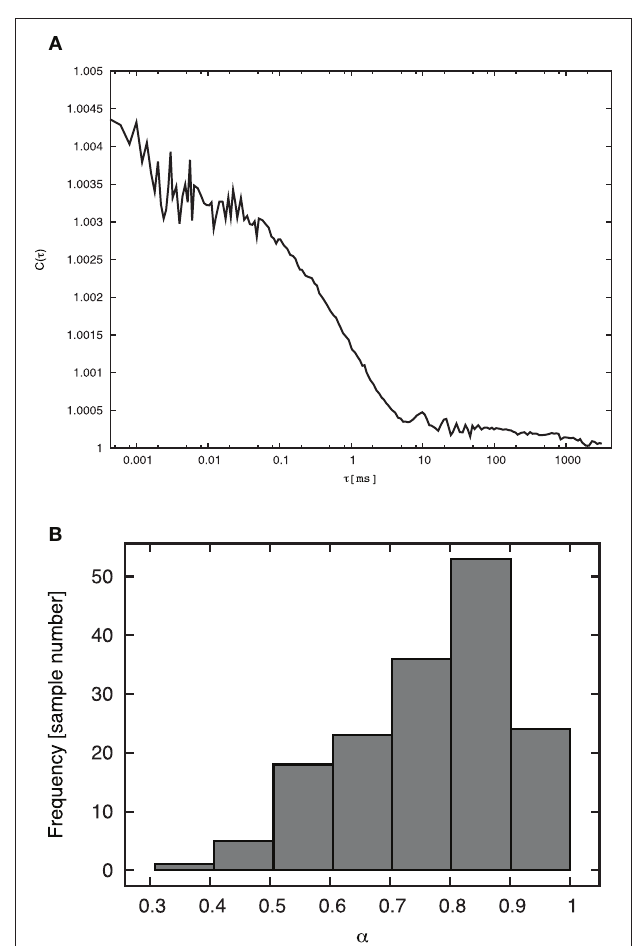
FiguRe 1 | estimated anomaly parameters based on 160 FCS data. (A) Relationship between diffusion time t and auto-correlation function C ( t ). This sample was obtained using a 45-μm diameter pinhole. Calibration was undertaken with R6G at four settings of the pinhole diameter (25, 35, 45, 75 μm; Hiroi et al., 2011). (B) The histogram indicates the distribution of the anomaly parameter a obtained from 160 measurements with GFP in the cytoplasmic